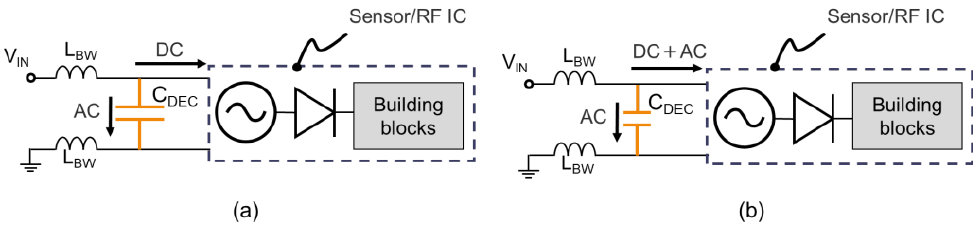
Figure 2. ( a ) Relatively large decoupling capacitor to filter out the AC component; ( b ) relatively small decoupling capacitor to create beat tones into the oscillator.